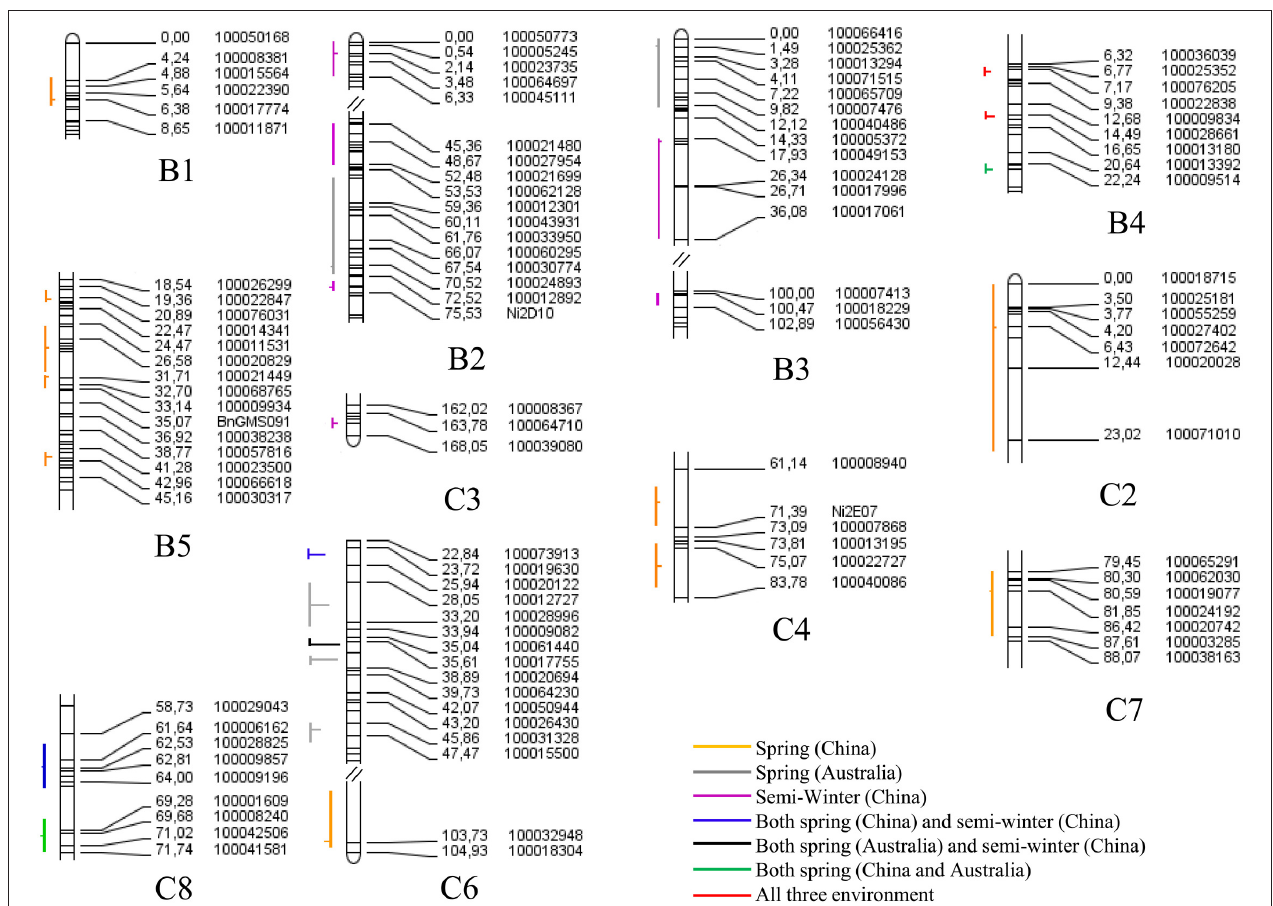
FIGURE 7 | The QTL controlling the flowering time in multiple environments of the YW DH population. All of the QTL are arranged to the left of each linkage group with vertical lines representing confidence interval, and the peak position of QTL is shown with a horizontal lines. The horizontal lines located to the left or right of the vertical lines represent the positive or negative additive effect. The lines with different color represent different environments.